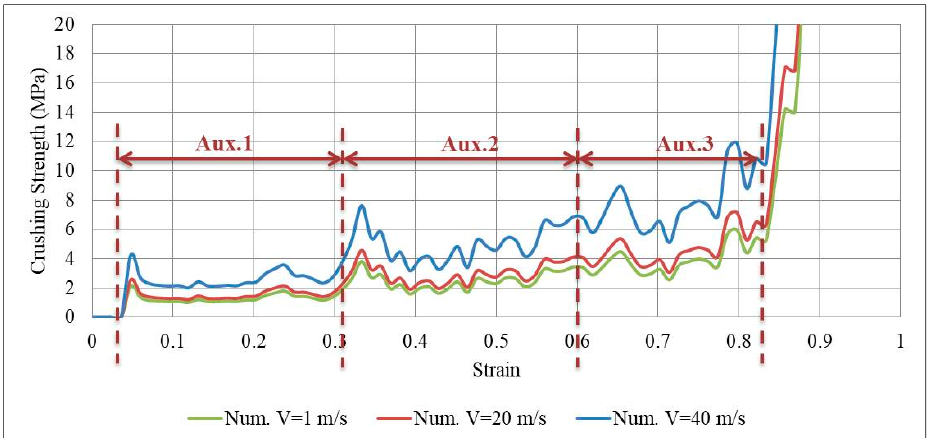
Figure 24. Numerical stress-strain curve of Aux. 1 under different impact velocities, compared to the analytical “dynamic crushing strength”.